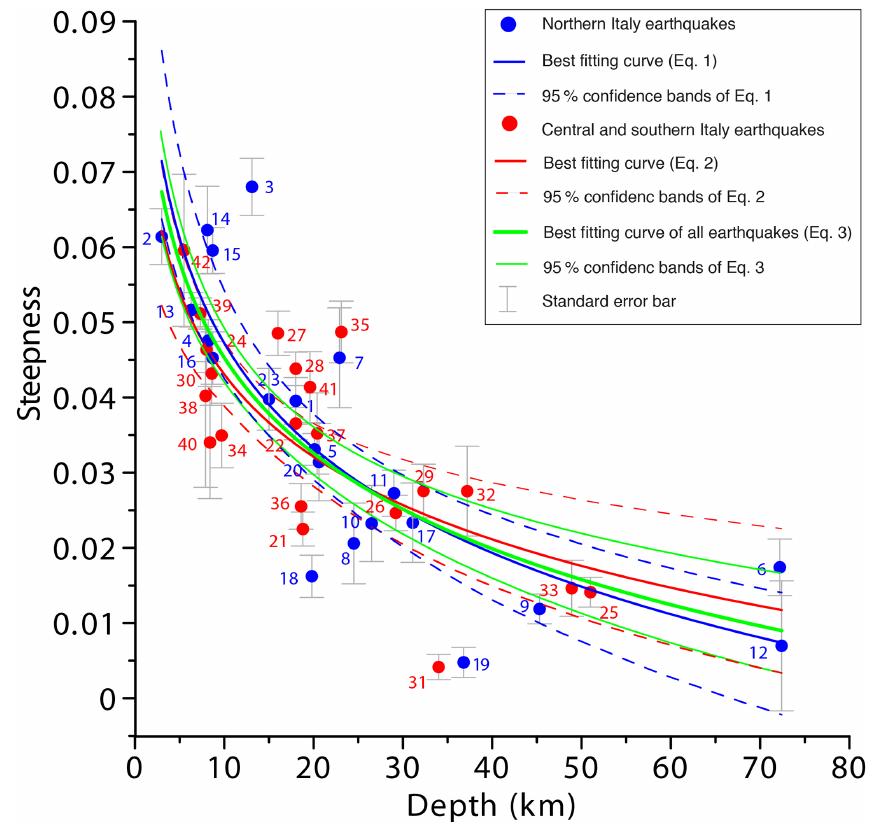
Figure 5. Depth versus attenuation steepness for the 42 earthquakes used as a learning set. Blue and red symbols indicate the northern Italian and the central and southern Italian datasets, respectively: the corresponding best-fitting logarithmic functions are shown in blue (Eq. 1) and red (Eq. 2), respectively, along with their 95% confidence bands. The best-fitting function obtained for the whole dataset (Eq. 3) is shown in green. Each earthquake is labeled with a unique identifier (see Table 1) and is plotted along with its standard error (shown by a vertical bar of ± standard